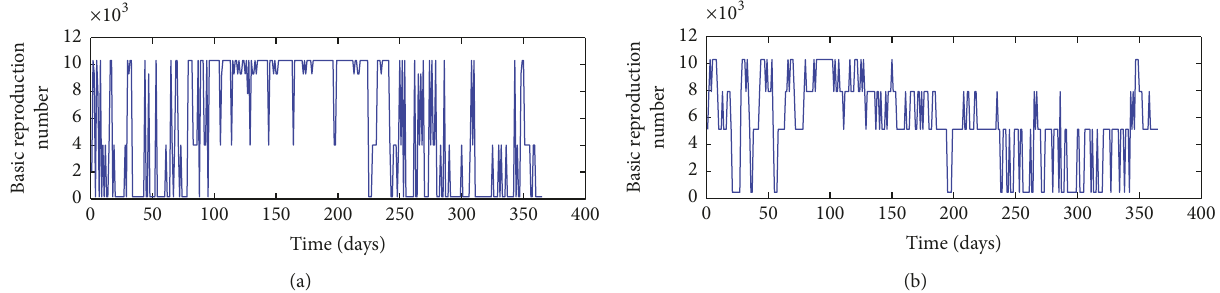
Figure 17: Distribution of 𝑅 0 based on fluctuation of temperature (a) and relative humidity (b) data in Singida.